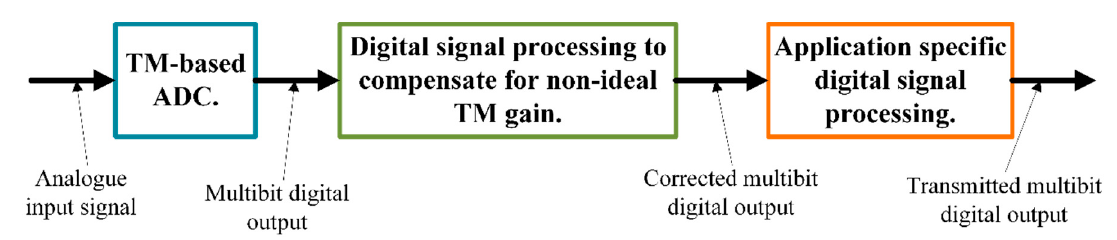
Figure 3. Block diagram of the proposed data acquisition (DAQ) system.